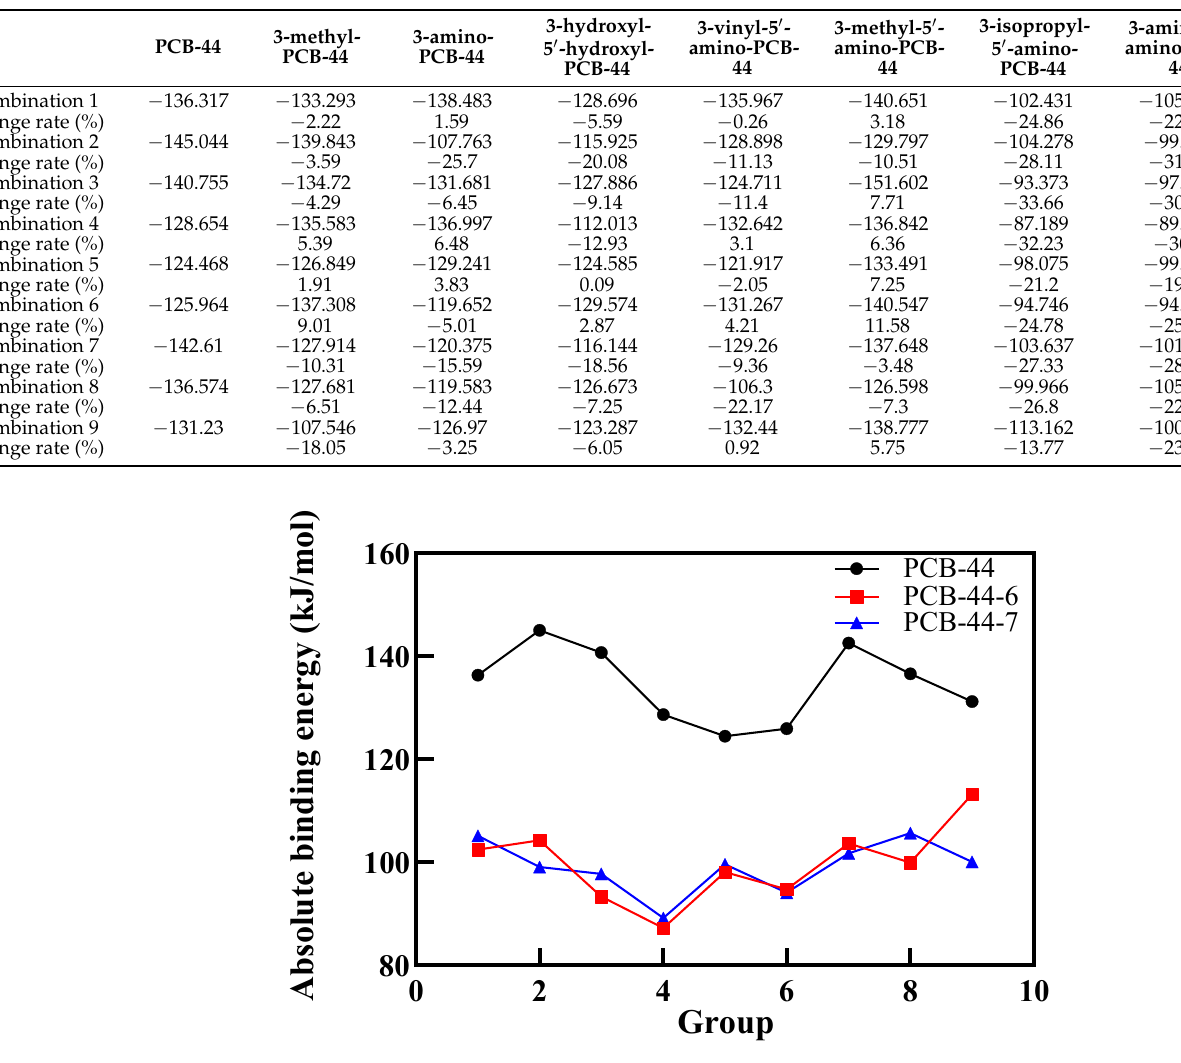
Figure 6. Binding energy of PCB-44, PCB-44-6, and PCB-44-7 molecules docked to oestrogen receptor binding under different combinations of components.